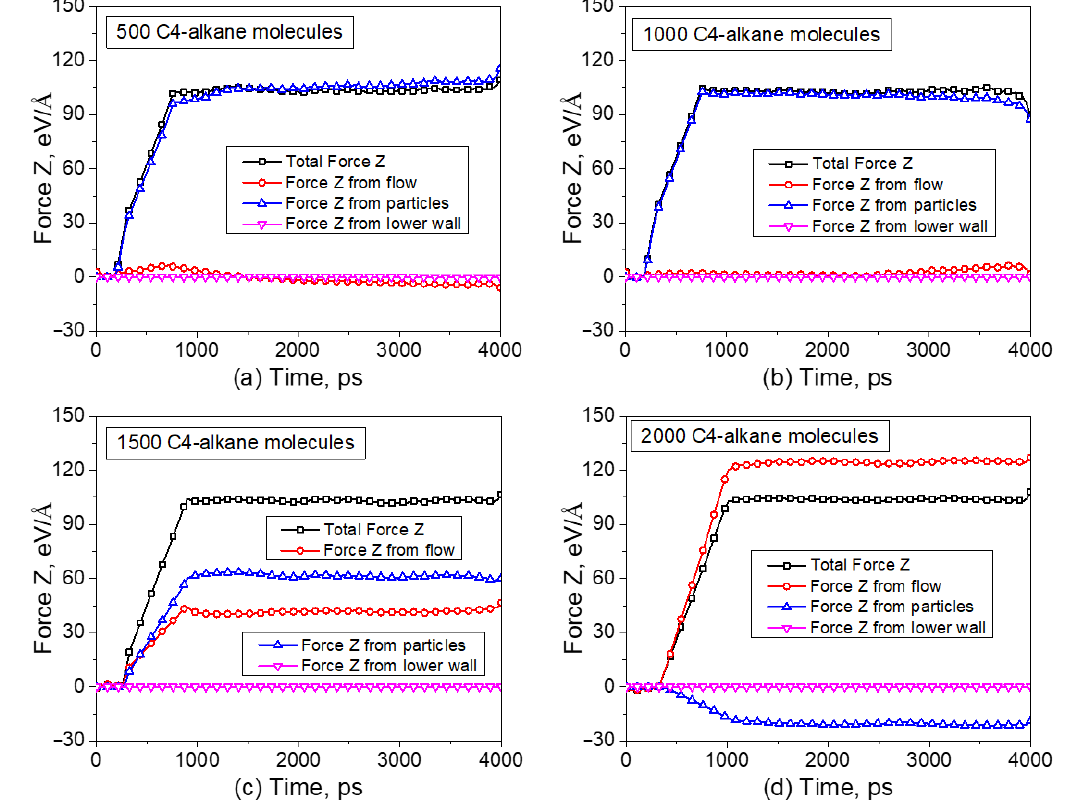
Figure 13. Influence of the number of C4-alkane molecules on the total force Z and its component from flow, nanoparticles and the lower wall: ( a ) 500, ( b ) 1000, ( c ) 1500 and ( d ) 2000 molecules.